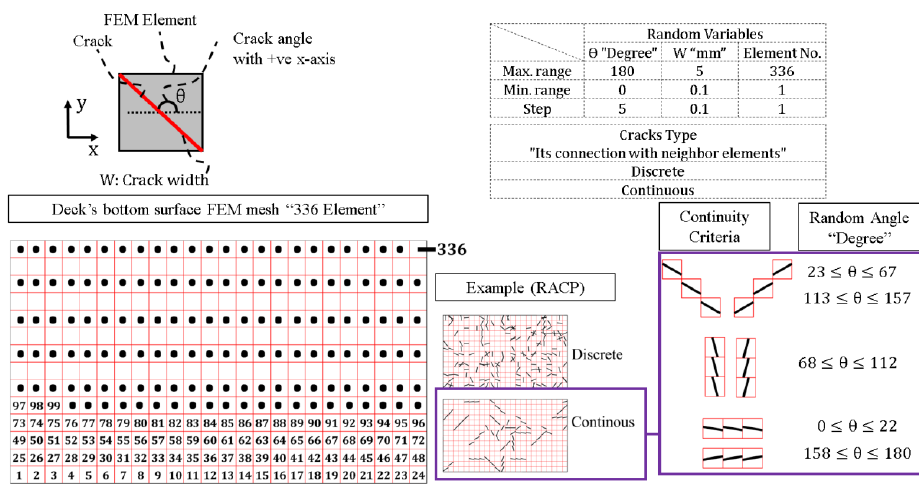
Figure 9. Randomized artificial crack patterns scheme.